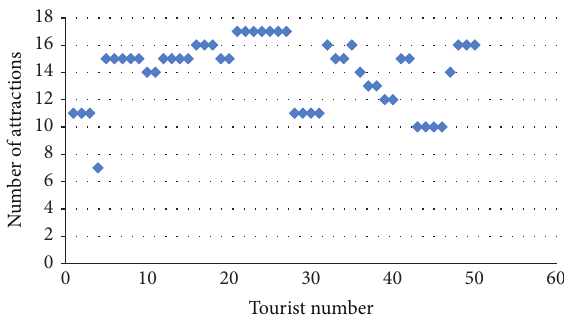
Figure 4: Number of attractions in tour route.